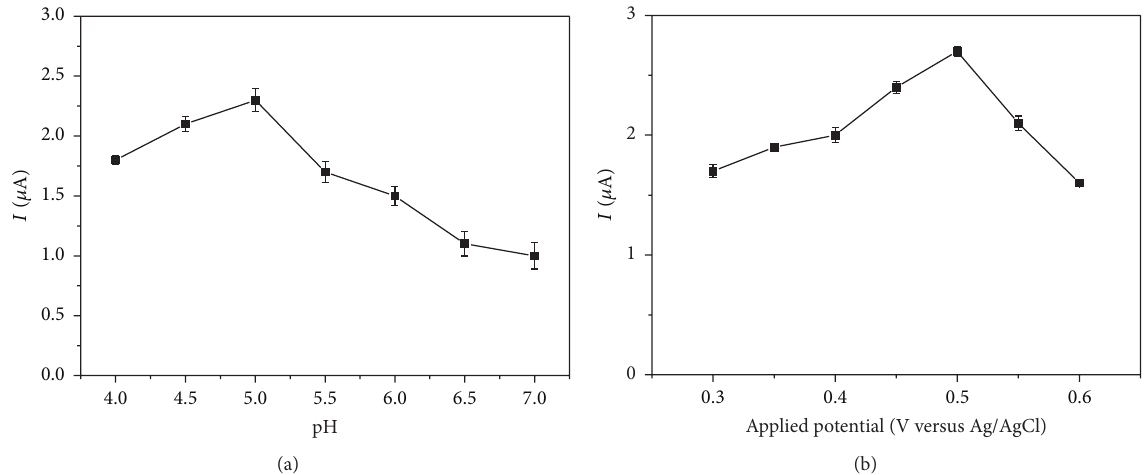
Figure 6: (a) The pH effects and (b) applied potentials of PDA-Lac-rGO-Pb/GCE on the catalytic currents of catechol in 0.1 M acetate buffer solution containing 100 𝜇 M